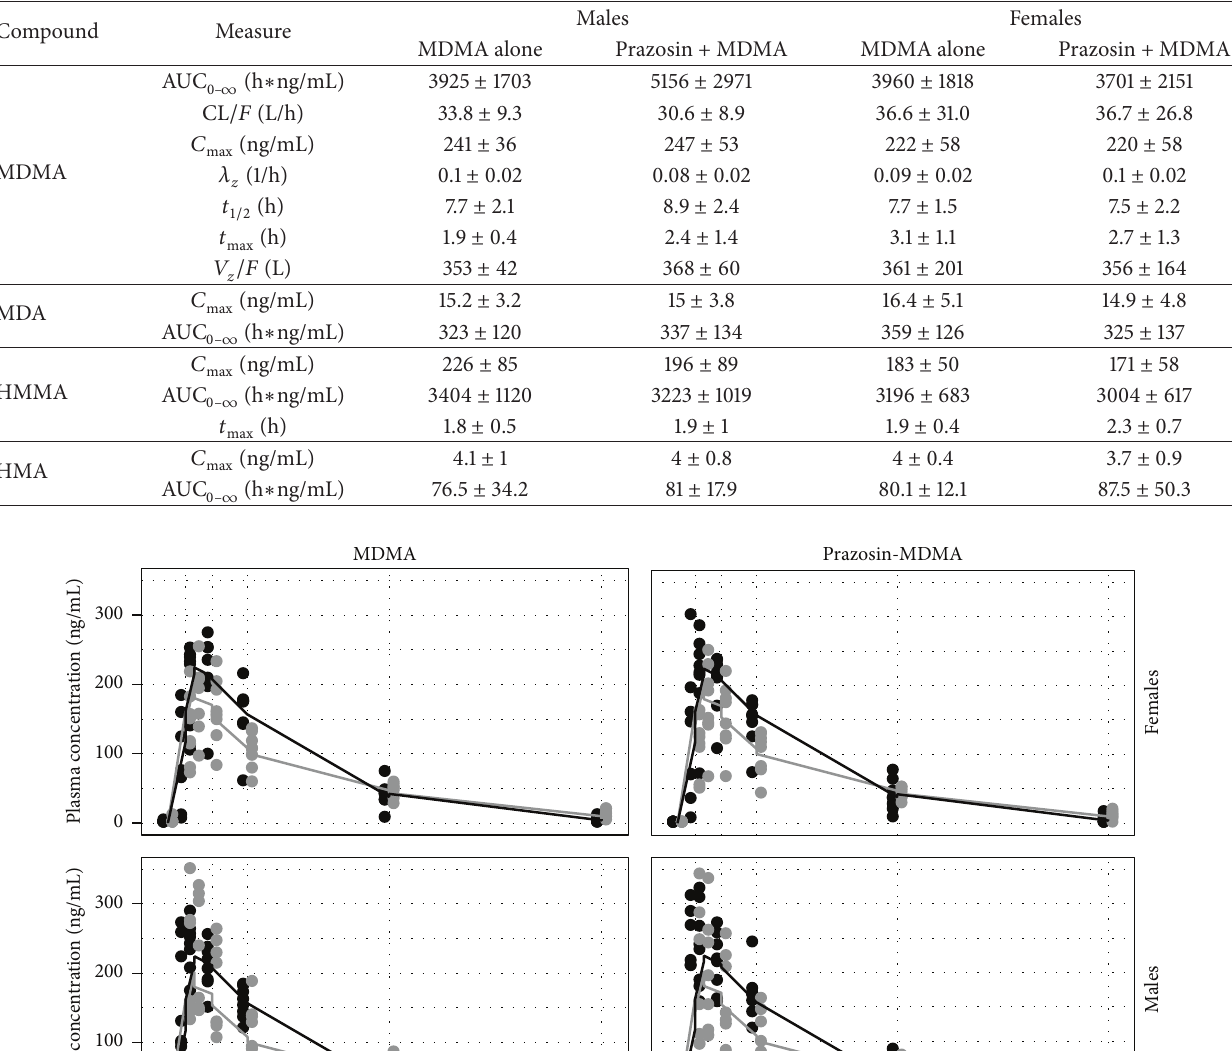
Table1:PharmacokineticresultsfromStudy1.Valuesaregivenasmean ± SD.AUC 0 CL /𝐹 : plasma clearance, 𝐶 max : maximum plasma concentration, 𝑡 max : time of maximum plasma concentration, 𝑉 𝑧 /𝐹 : apparent volume of distribution, 𝜆 𝑧 : first-order elimination constant, and 𝑡 1/2 : half-life.